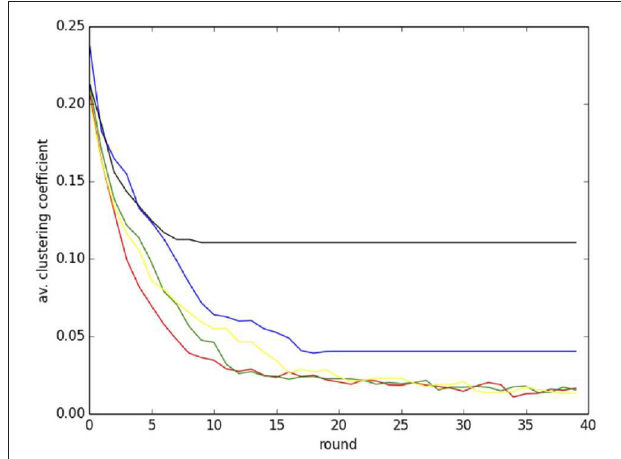
FIGURE 5 | Evolution of the average clustering coefficient during a run of 40 rounds for the same r values as in Table 1 . Color codes: r = 1.2, red; r = 1.8, green; r = 2.0, yellow; r = 2.2, blue; r = 2.4, black.